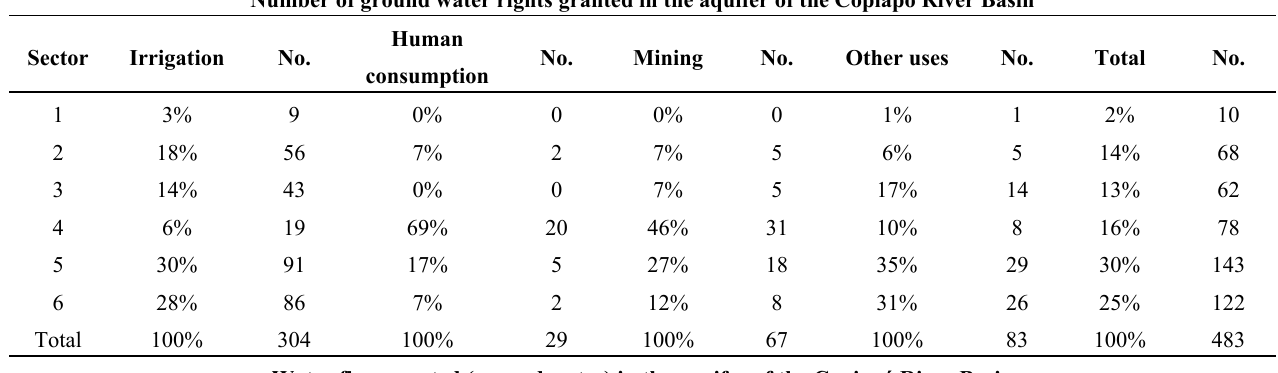
Table 4. Distribution of the groundwater rights granted in the aquifer of the Copiapó River